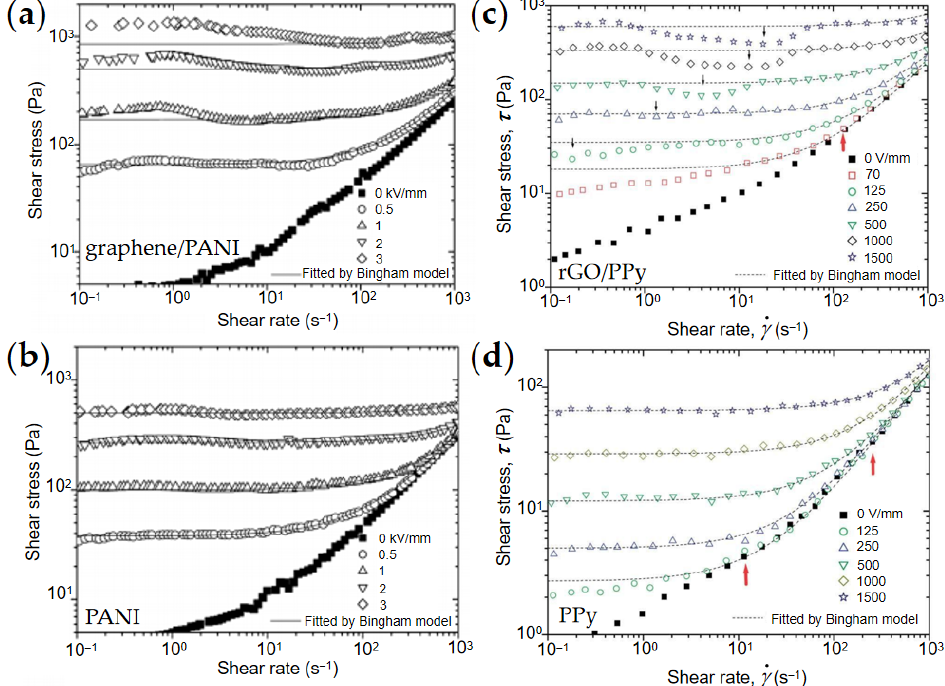
Figure 10. Flow curves of shear rate–shear stress of ER fluids of GO/SiO 2 ( a ) and GO/PANI ( b ); The solid and dashed lines are fitted by CCJ and Bingham models, respectively [93,94].